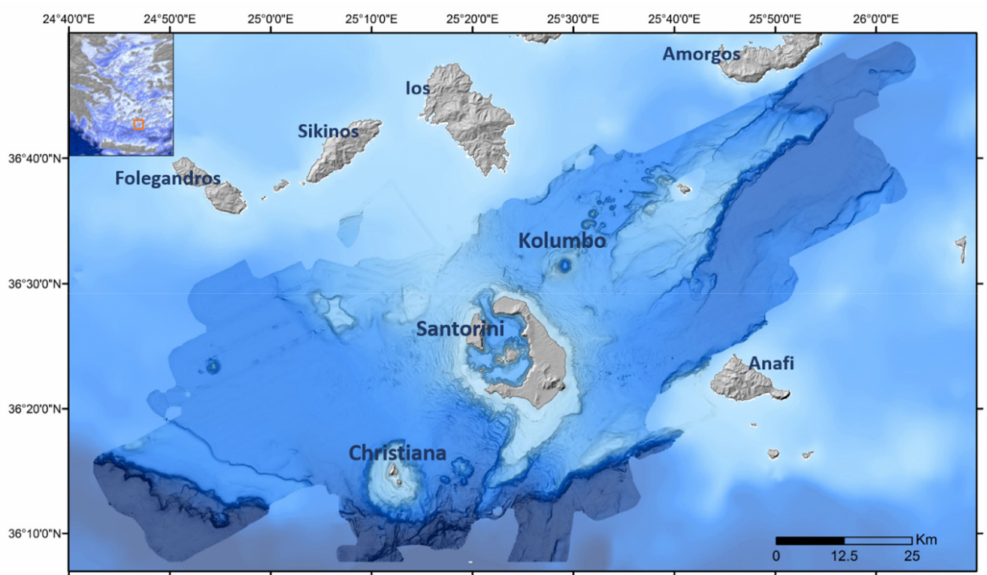
Figure 10. Map showing the exact location of the Santorini volcanic field within the Aegean Sea.